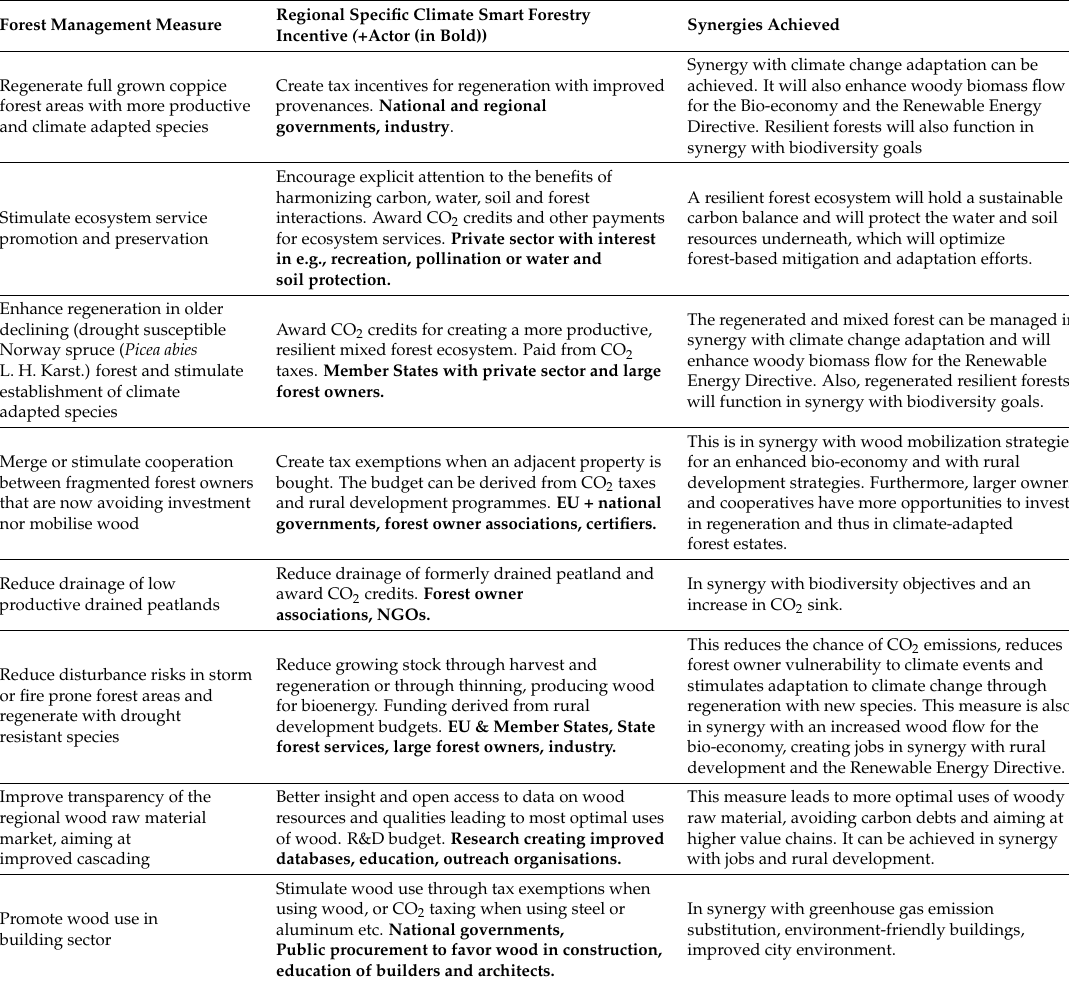
Table 2. Examples of measures for implementing Climate Smart Forestry and their local